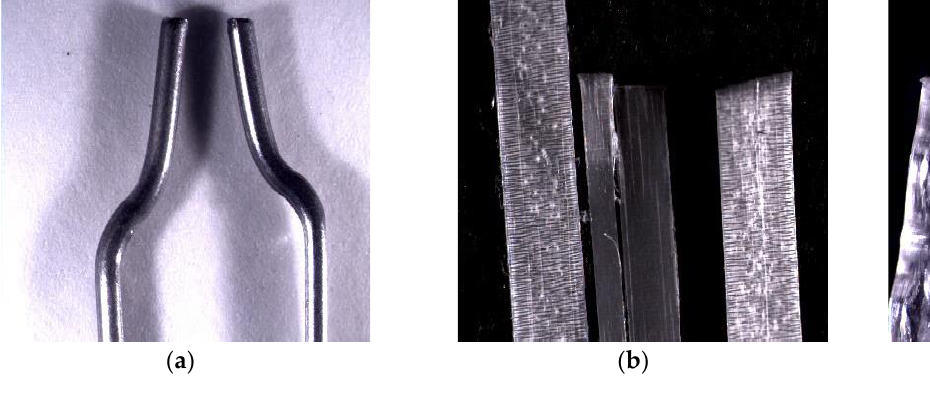
Figure 1. ( a ) DE 35/0.55 steel fibers; ( b ) Strux PP fibers; ( c ) Durus PP fibers. As regards the concrete mix design, water-to-cement ratio was W/C = 0.3 in each group. Other ingredient amounts are given in Table 2. Volumetric concentration of fibres in the mixes was 1.0% and 0.1% from the total volume of a concrete, according to the Table 3. Table 2. Designed concrete mix composition and used components.